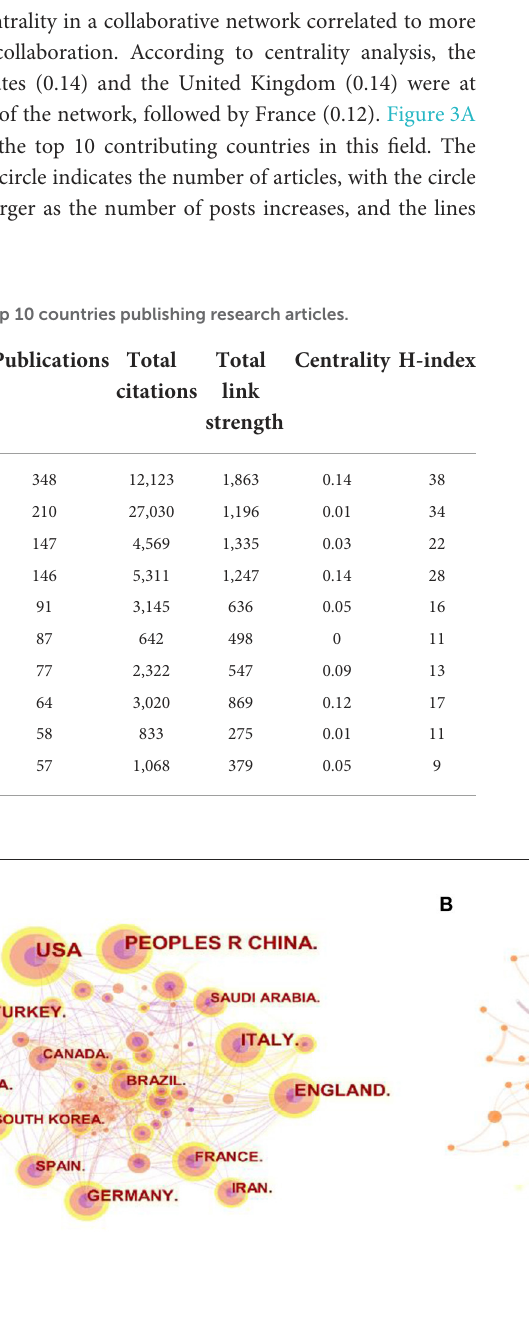
FIGURE3 Visualization map of the scientific collaboration network analysis of COVID-19 and otorhinolaryngology research field. Collaboration among countries/regions (A) and institutions (B)